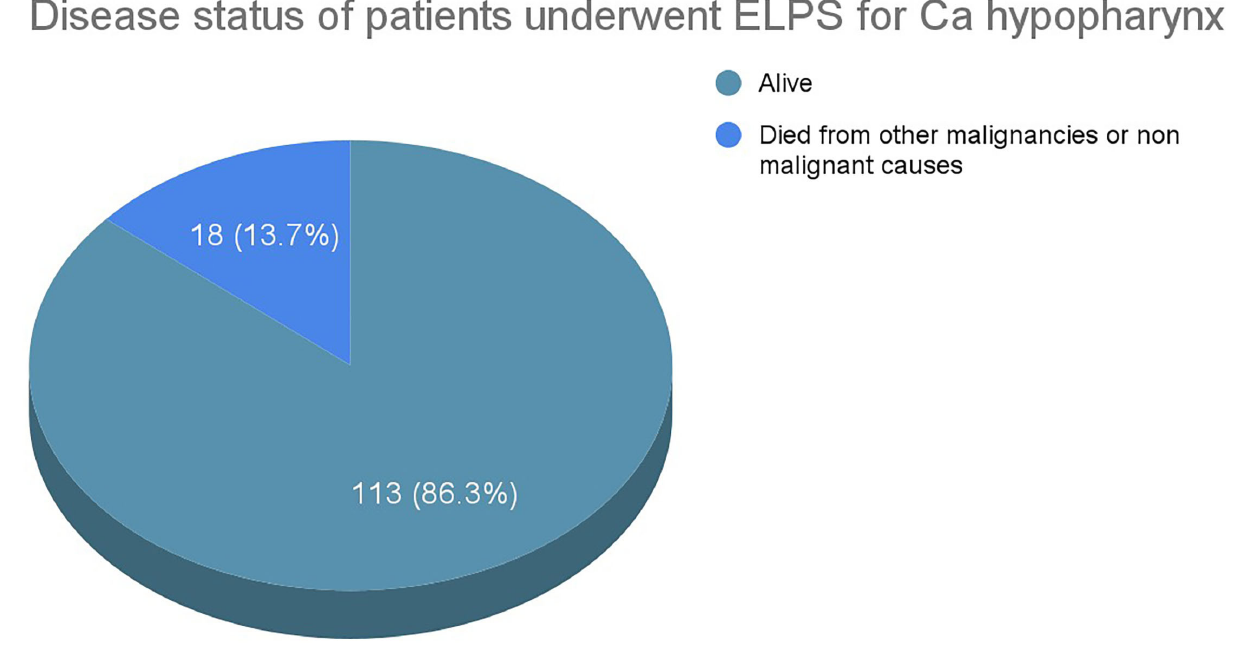
FIGURE 8 | Disease status of ELPS